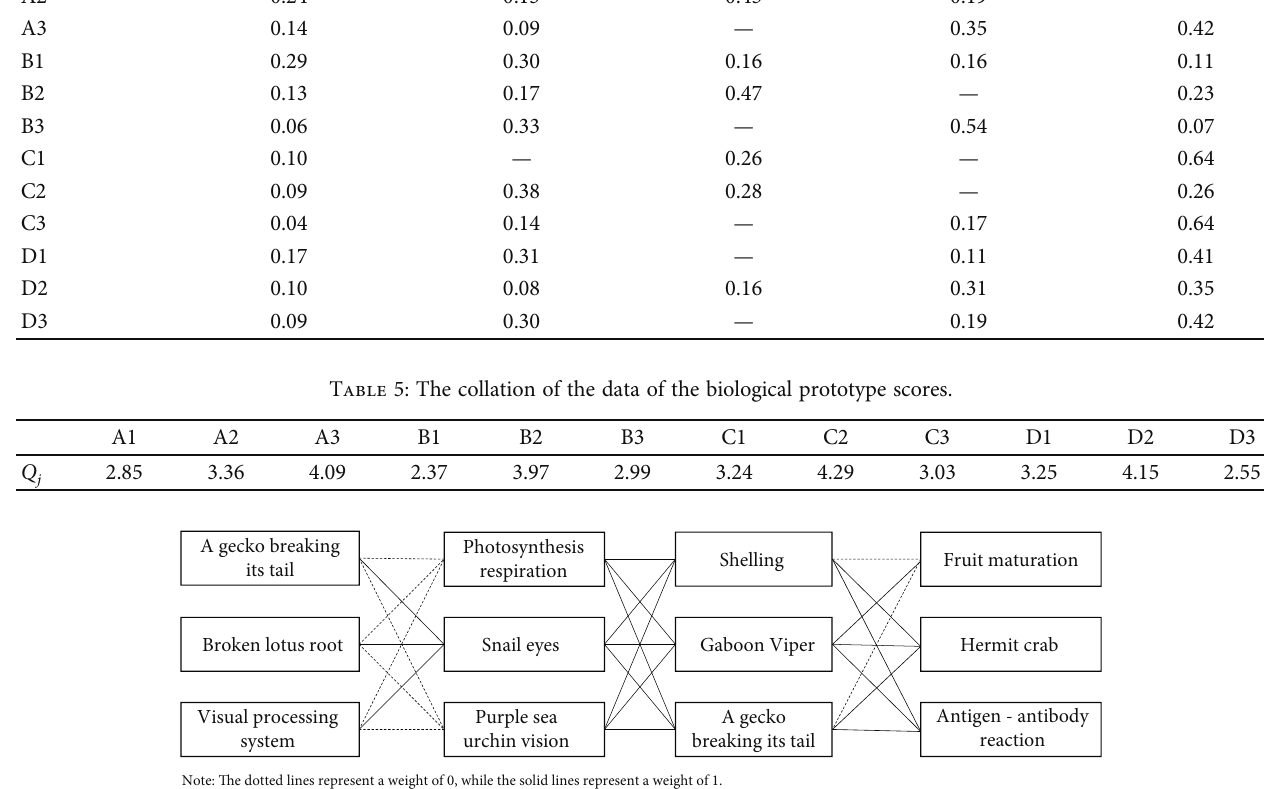
Figure 7: The analysis of the impacts between biological